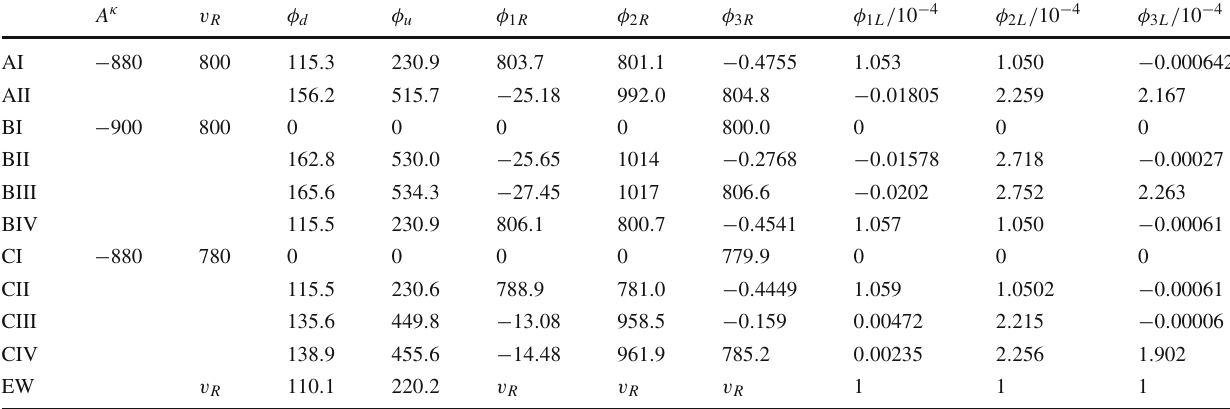
Table 2 Field values of unphysical local minima for which S E < 700 are given for three selected parameter points. The last row shows the field values of the EW minimum, which are the same for the three parameter points. Dimensionful parameters and field values are given in GeV A κ v R φ d